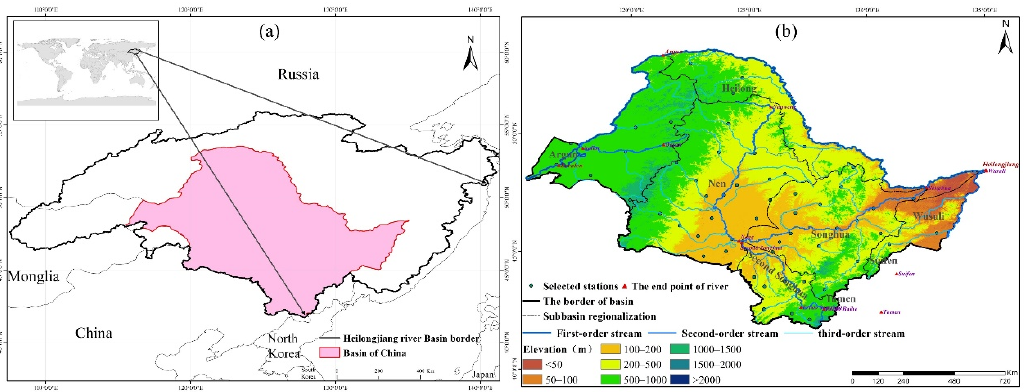
Figure 1. General condition of the Heilongjiang River basin, China: ( a ) Location of study site; and ( b ) selected meteorological sites, elevation distribution, and regionalization.